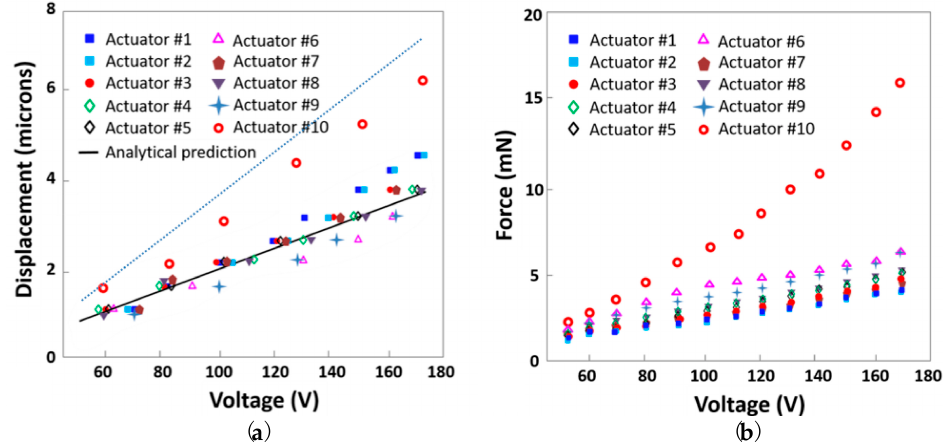
Figure 4. ( a ) Measured peak-to-peak displacement of the actuators as described in Table 1 vs. applied voltage. ( b ) Measured blocking force of the actuators vs. applied voltage.